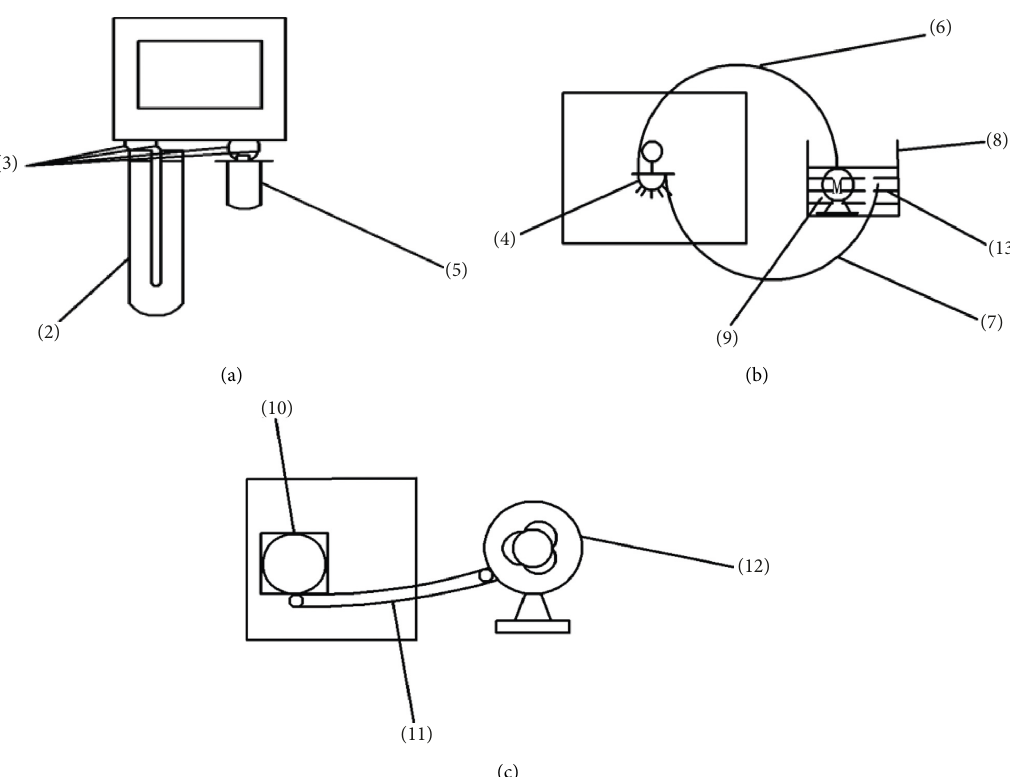
Figure 4: (a) Thermostatic system. (b) Spraying system. (c) Exhaust